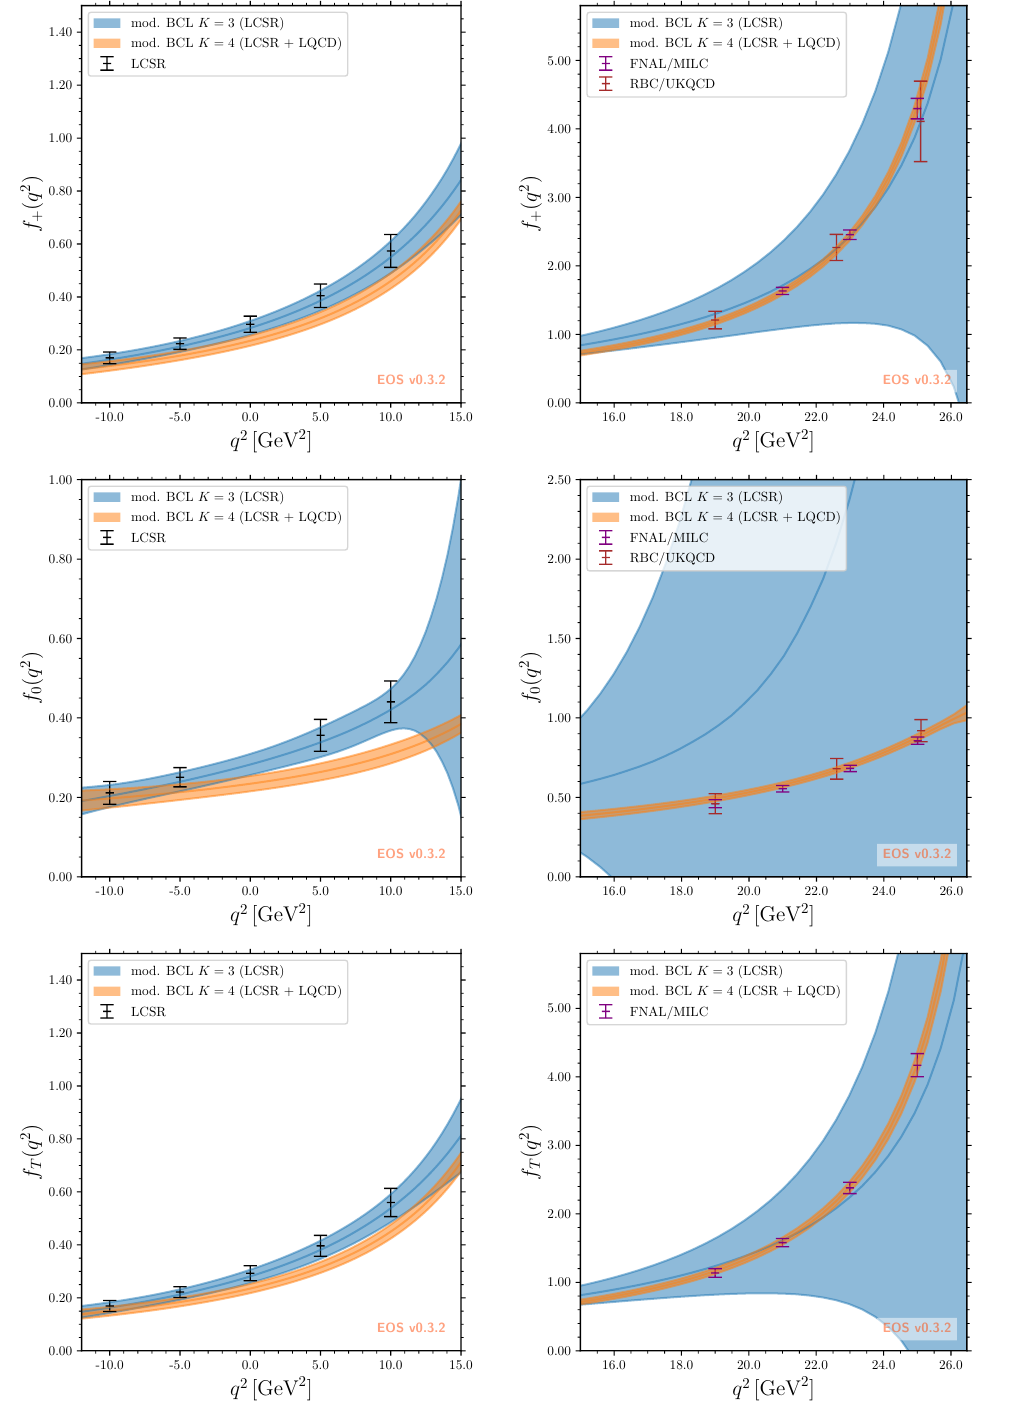
Figure 5 . Posterior-predictions for the form factors f + (top), f 0 (center), and f T (bottom) obtained from our fits of the modified BCL parametrization (4.1) to the LCSR pseudo data points only (blue bands), and both the LCSR and lattice QCD inputs (orange bands). The bands correspond to the envelope at 68%